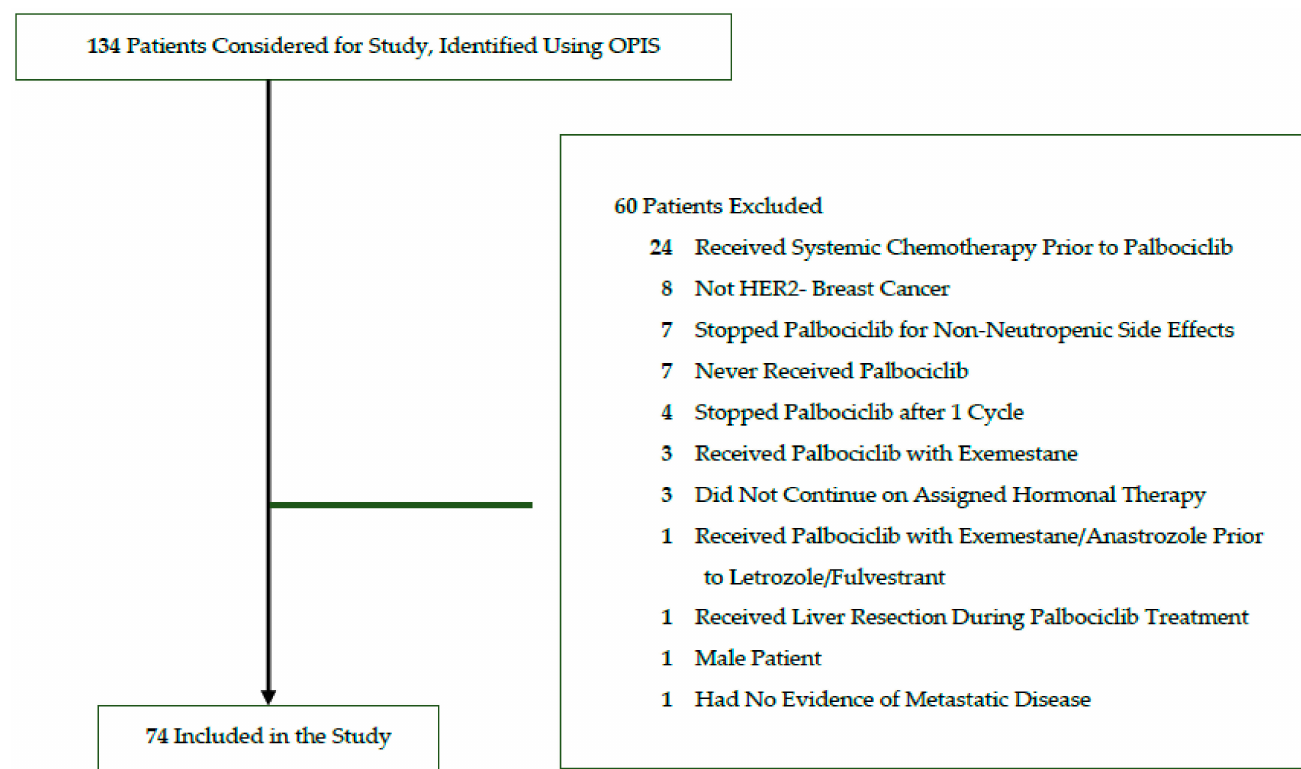
Figure 2. Study flow diagram for identified and included